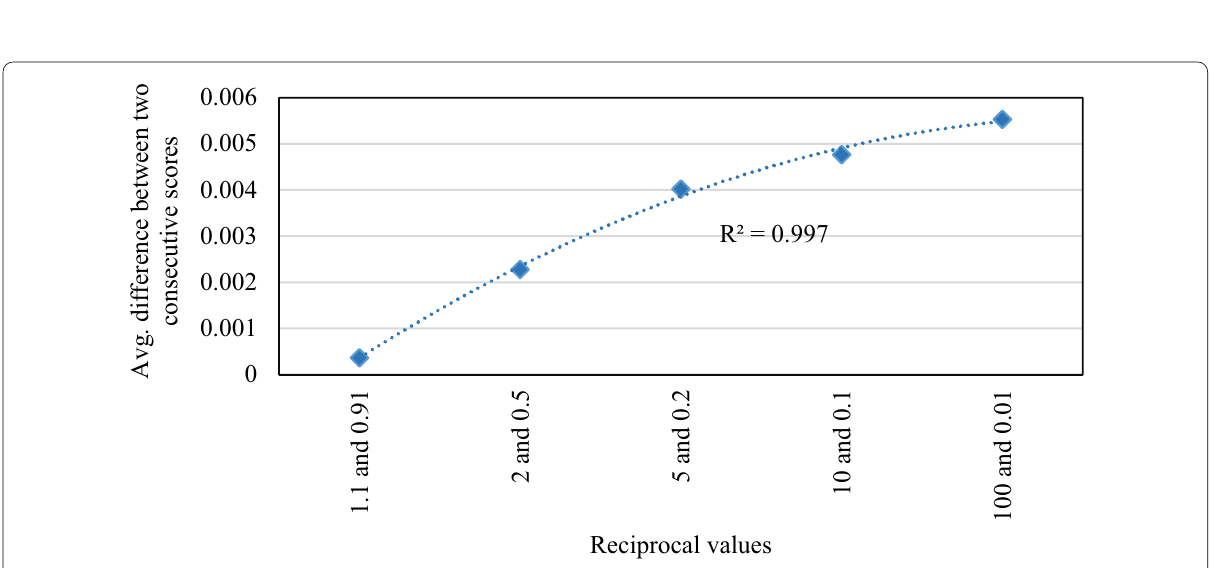
Fig. 4 Avg. difference between consecutive scores when using other reciprocal